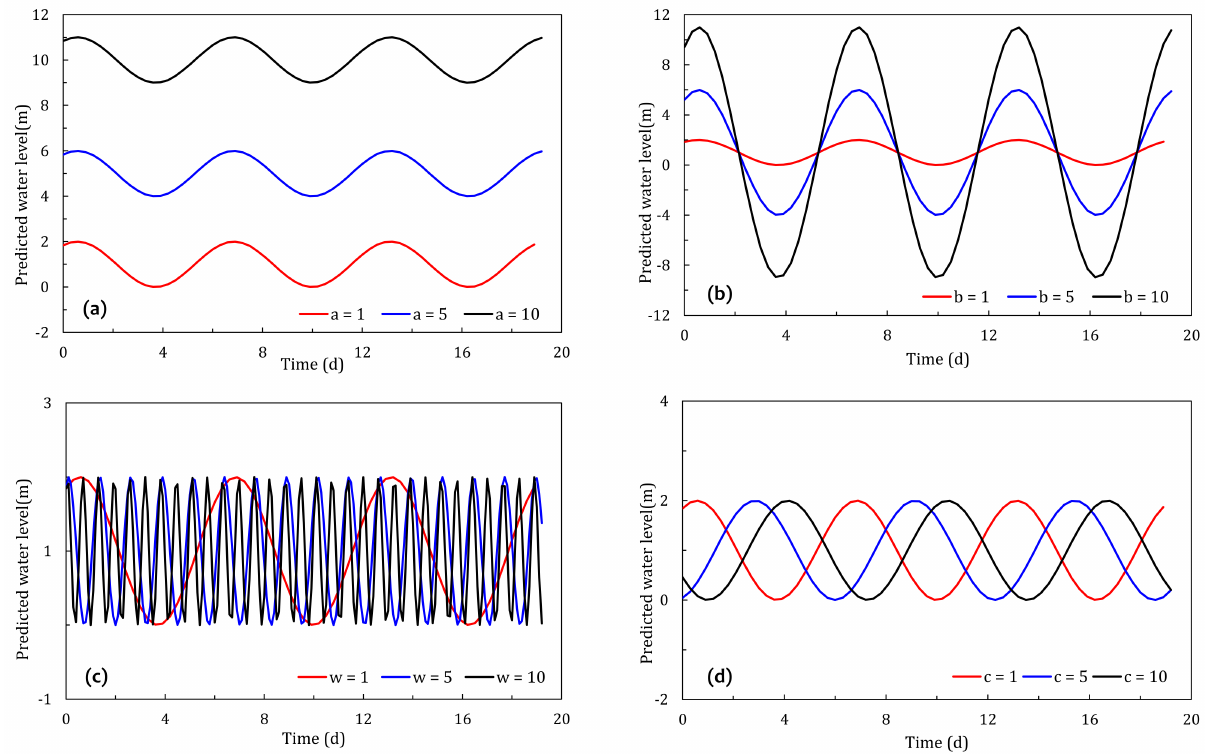
Figure 6. Different values of the parameters in Equation (1): ( a ) a = 1, a = 5, and a = 10; ( b ) b = 1, b = 5, and b = 10; ( c ) ω = 1, ω = 5, and ω = 10; and ( d ) c = 1, c = 5, and c =